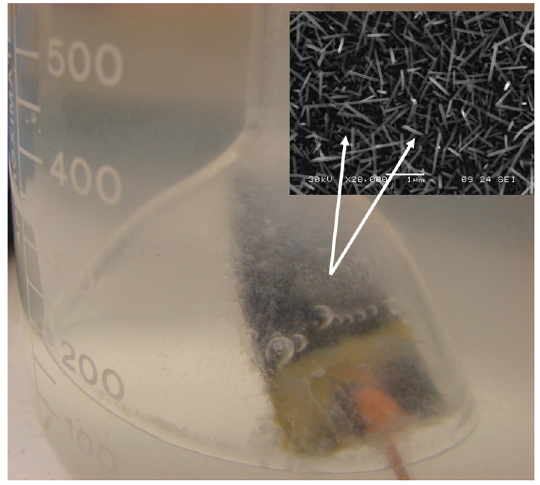
Figure 7. Photo of bubble formation on RuO 2 nanorod decorated surface (Si wafer). The nanorods are located on the surface of the wafer (see insert).